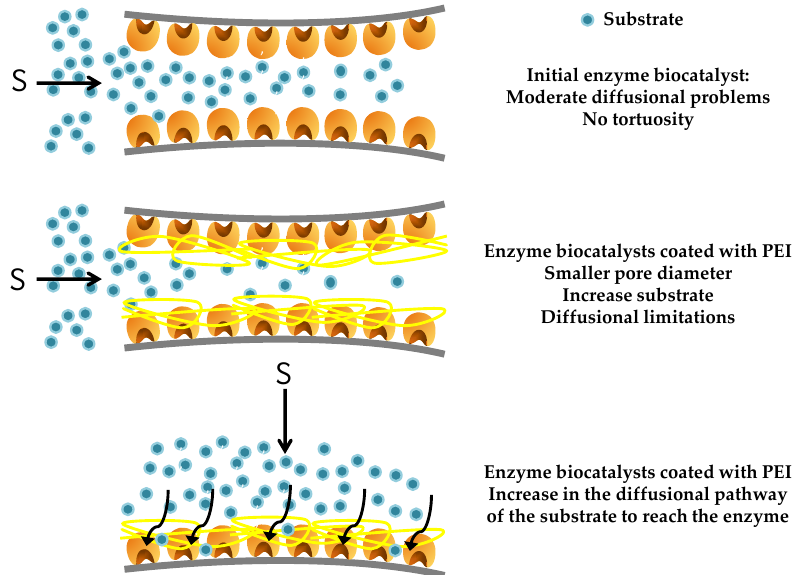
Figure 8. Schematic representation of the problems generated by the polyethylenimine (PEI) coating in the expressed activity of the biocatalysts.